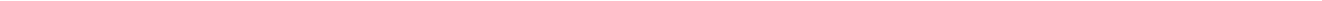
site usage and color-coded, and the IpA isoforms with signi fi cantly different usage compared to PCs are shown (FDR-adjusted P < 0.05, lower usage of IpA sites in MM, n = 480; higher usage of IpA sites in MM, n = 15, not shown). b As in Fig. 3d, but for MM group 1 versus PCs. Full-length and IpA isoform expression is shown and signi fi cantly different IpA isoforms are color-coded (FDR-adjusted P < 0.05). c As in Fig. 3b. Shown is a signi fi cant upregulation of full-length mRNA isoform expression (one-sided KS test, P < 10 − 8 ) of genes highlighted in blue in ( b ). d Independent set of patients with RNA-seq expression ( n = 286) were classi fi ed into two groups based on the IpA usage of a gene signature (see Methods). Patients in group A- fi ltered (n = 64) exhibit loss of recognition of IpA sites, while patients in group B- fi ltered ( n = 100) exhibit higher usage of IpA sites like the PCs. Group B- fi ltered patients have signi fi cantly improved ( P < 0.028) progression-free survival than group A patients. e Examples of IpA isoforms expressed in PCs, but signi fi cantly decreased in MM samples. Shown as in Fig. 1b. f Validation of expression levels of IpA isoforms from e in terms of usage by